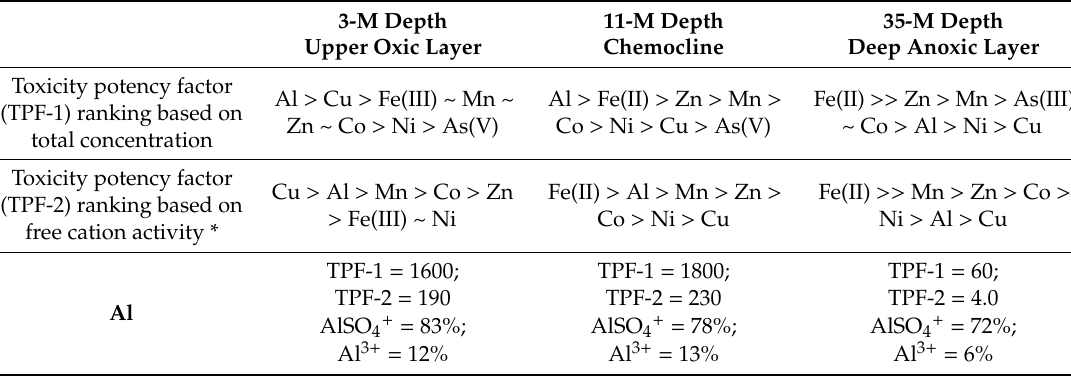
Table 2. Summary of toxic potency factors and geochemical speciation modeling for the three layers of Cueva de la Mora. Toxicity rankings were based on total element concentration or free cation activity divided by its corresponding USEPA National Ambient Water Quality Criteria constant contact concentration factor (NAWQC-CCCF) numerical standard (Table 1). Speciation results were calculated using PHREEQC for each lake layer and include predominant species % and free cation